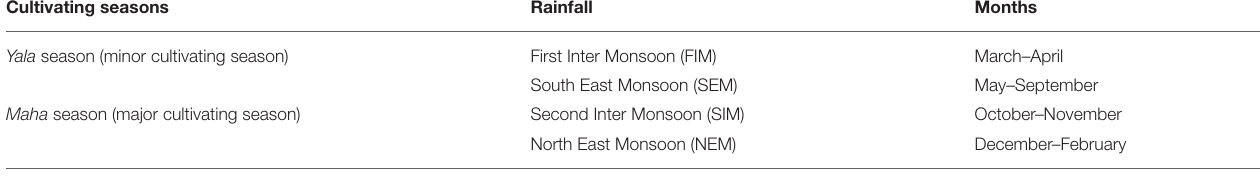
TABLE 1 | Rainfall and cultivating seasons and vital atmospheric parameters of Sri Lanka (source: Punyawardena, 2007). Cultivating seasons